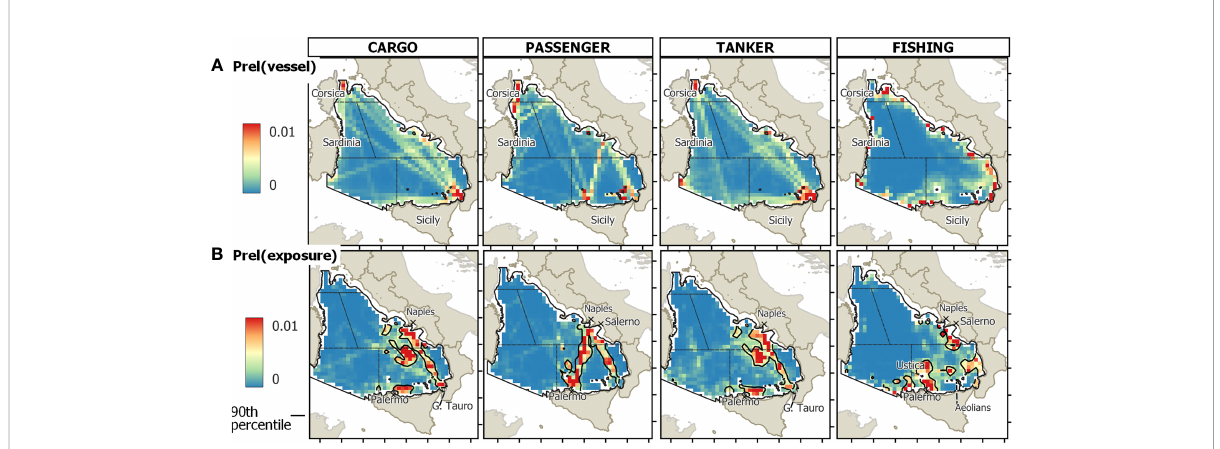
FIGURE 6 The oceanic TYS study area divided into cells of 15 km 2 (688 cells); colors indicate the relative probability (A) vessel occurrence, (B) total vessel and turtle co-occurrence, calculated over the yearly average sorted by the type of vessel (Cargo, Passenger, Tanker, and Fishing). The loggerhead turtle occurrences included in the risk analysis correspond to that already reported in Figure 5 and referred to the whole